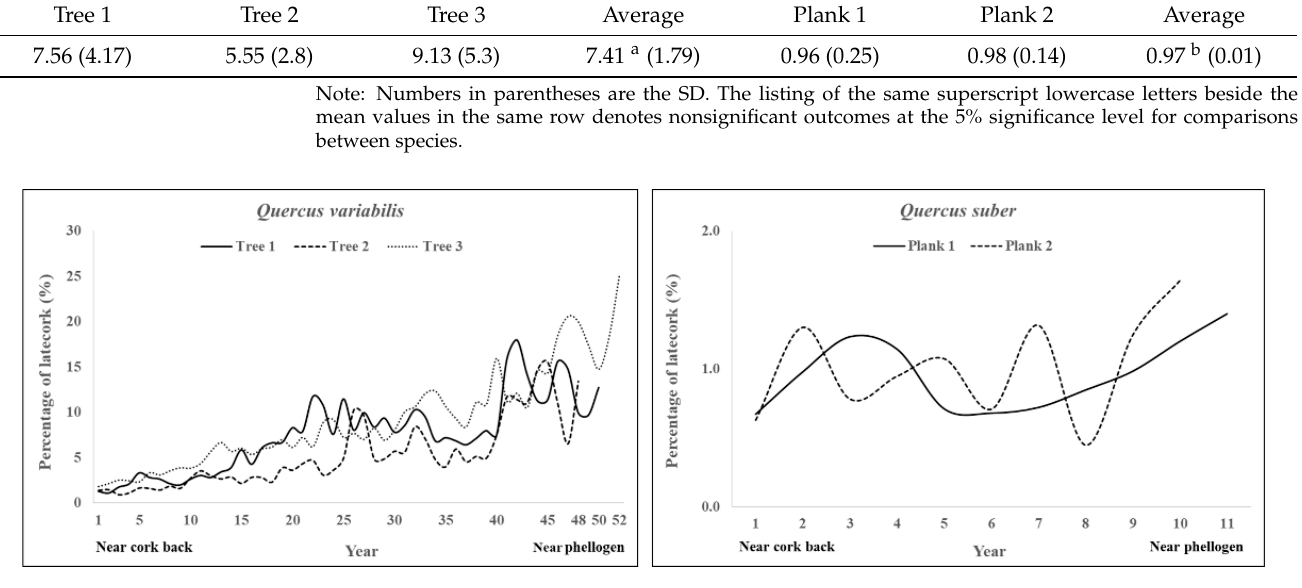
Figure 4. Variation of latecork percentage from the cork back to the phellogen in Q. variabilis virgin cork and Q. suber reproduction cork.